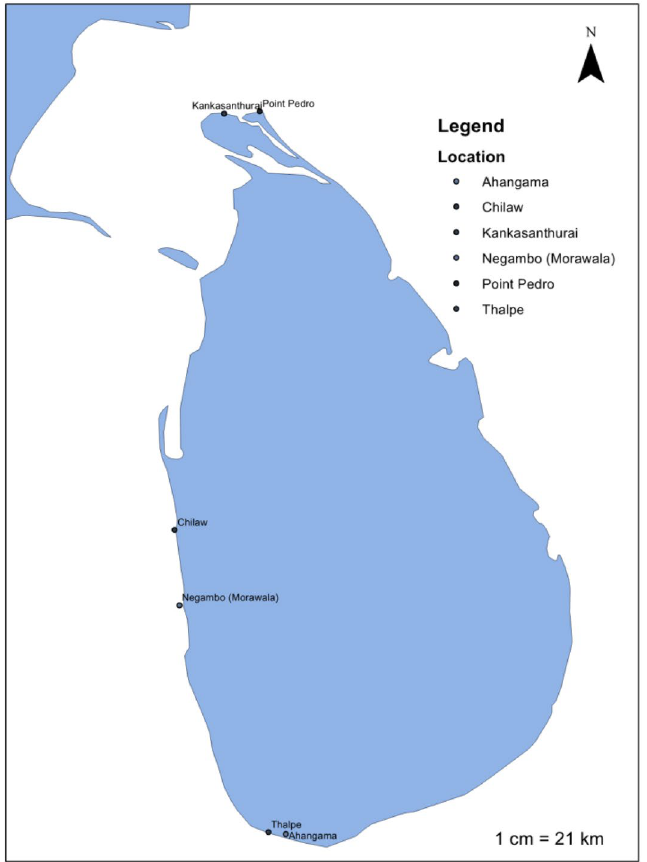
Figure 1. Map of seaweed samples collection location. (01) Ahangama (N 05°58.006’ E 080°22.482’), (02). Thalpe (N 05°59.792’ E 080°16.898’), (03) Chilaw (N 07°36.220’ E 079°47.120’), (04) Negombo (N 07°12.170’ E 079°48.570’), (05) Kankasanthurai (N 09°48.592’ E 080°02.546’), (06) Point Pedro (N 09°49.501’ E 080°15.119’) (ArcGIS for Desktop 10.3.1 version was used to create the map—https:// www. esri. com/ en- us/ arcgis/ produ cts/ arcgis- deskt op/ overv